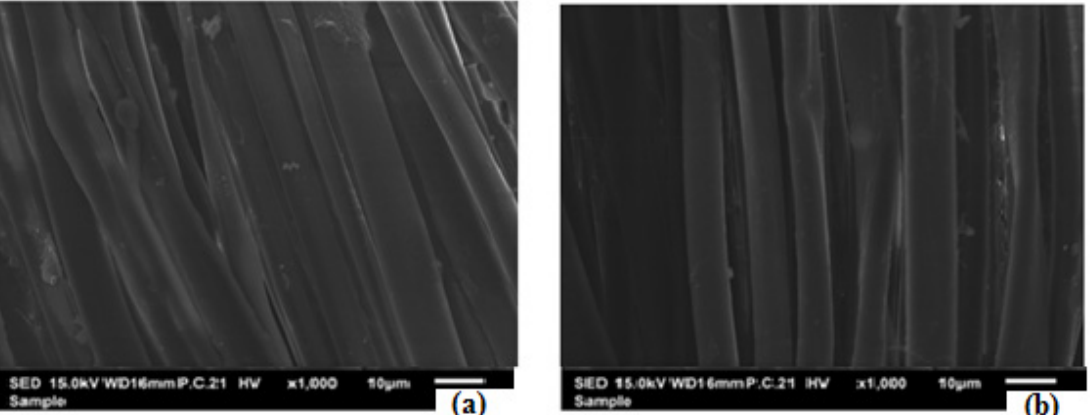
Figure 4. SEM analysis un irradiated silk fabric ( a ), irradiated silk fabric ( b ).